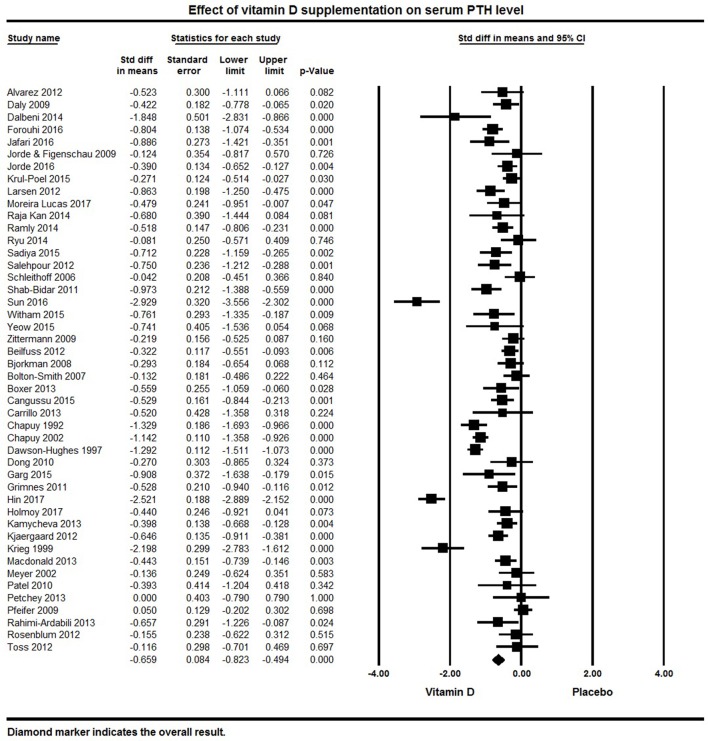
Forest plot detailing standardized mean difference for the impact of vitamin D on serum PTH level.